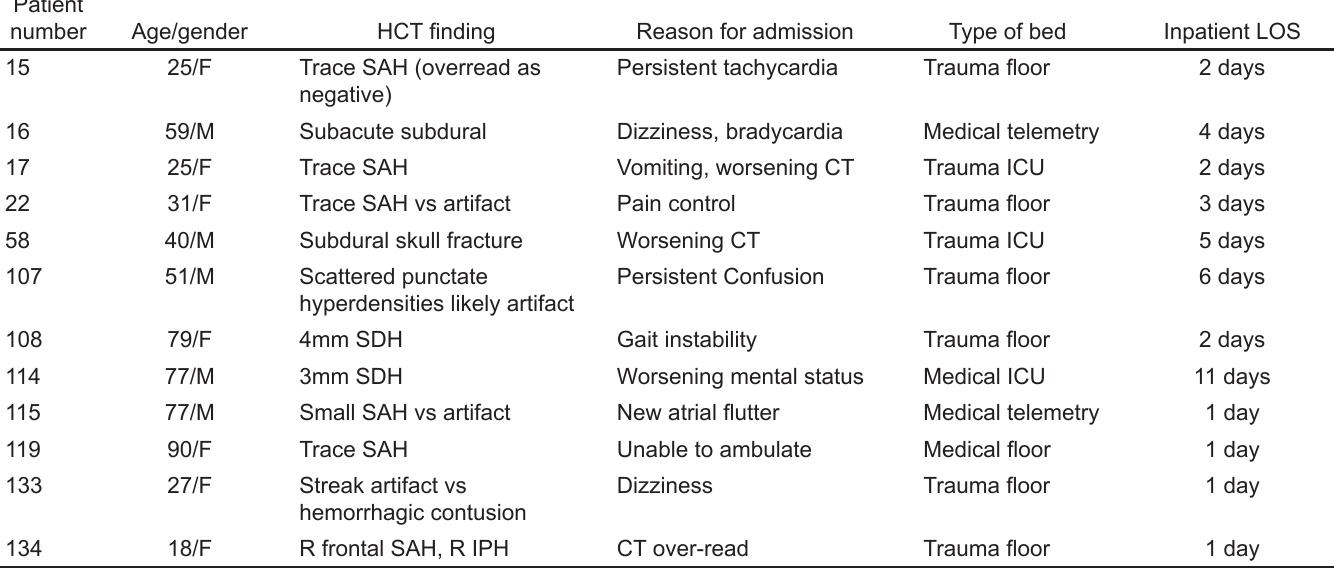
Table 4. Patients admitted following emergency department observation unit observation